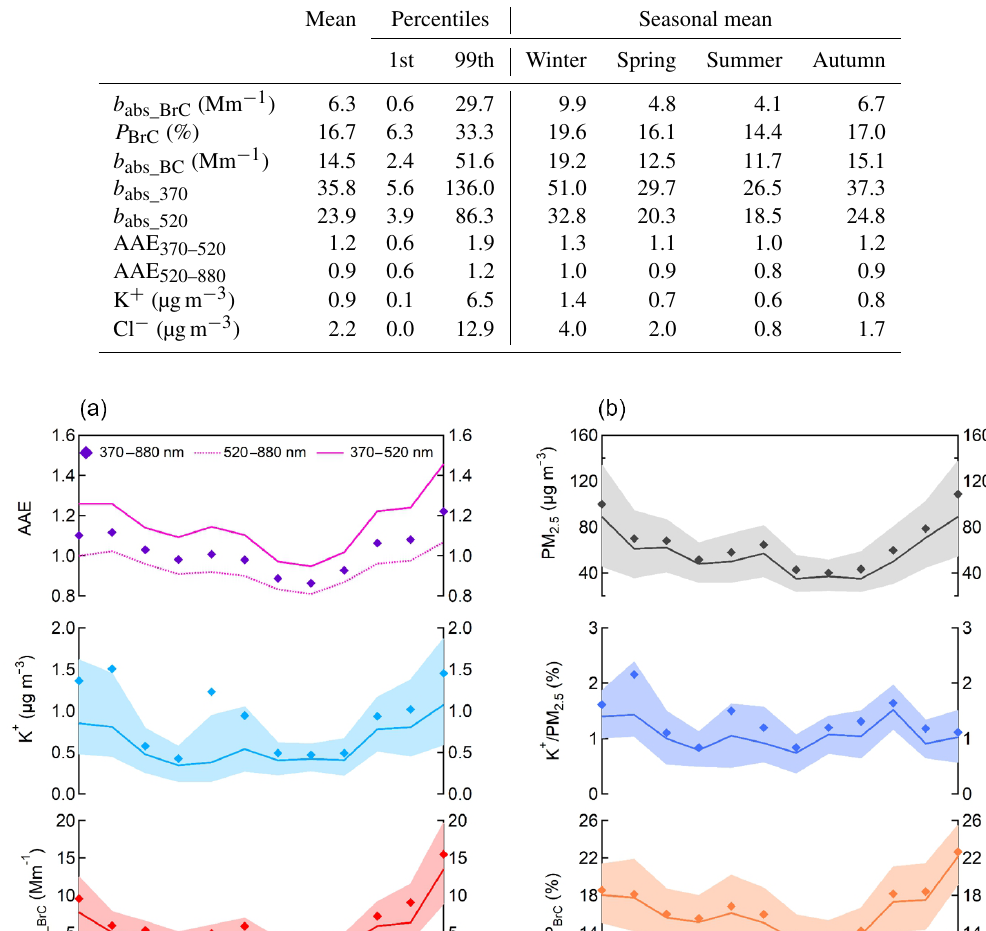
Table 1. Statistical summary of data measured at the SORPES station.